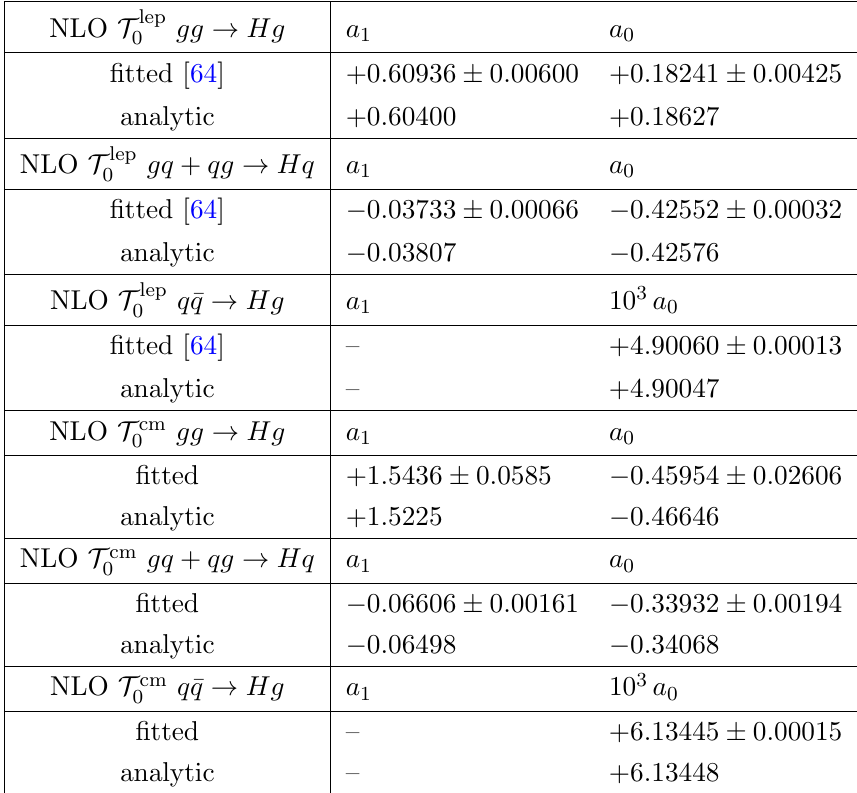
Table 2 . Comparison between our analytic predictions and the (cid:12)tted results for the LL a 1 and NLL a 0 coe(cid:14)cients in Higgs production. These (cid:12)tted values for a 1 and a 0 with the leptonic de(cid:12)nition and the analytic results for a 1 were already given in ref.